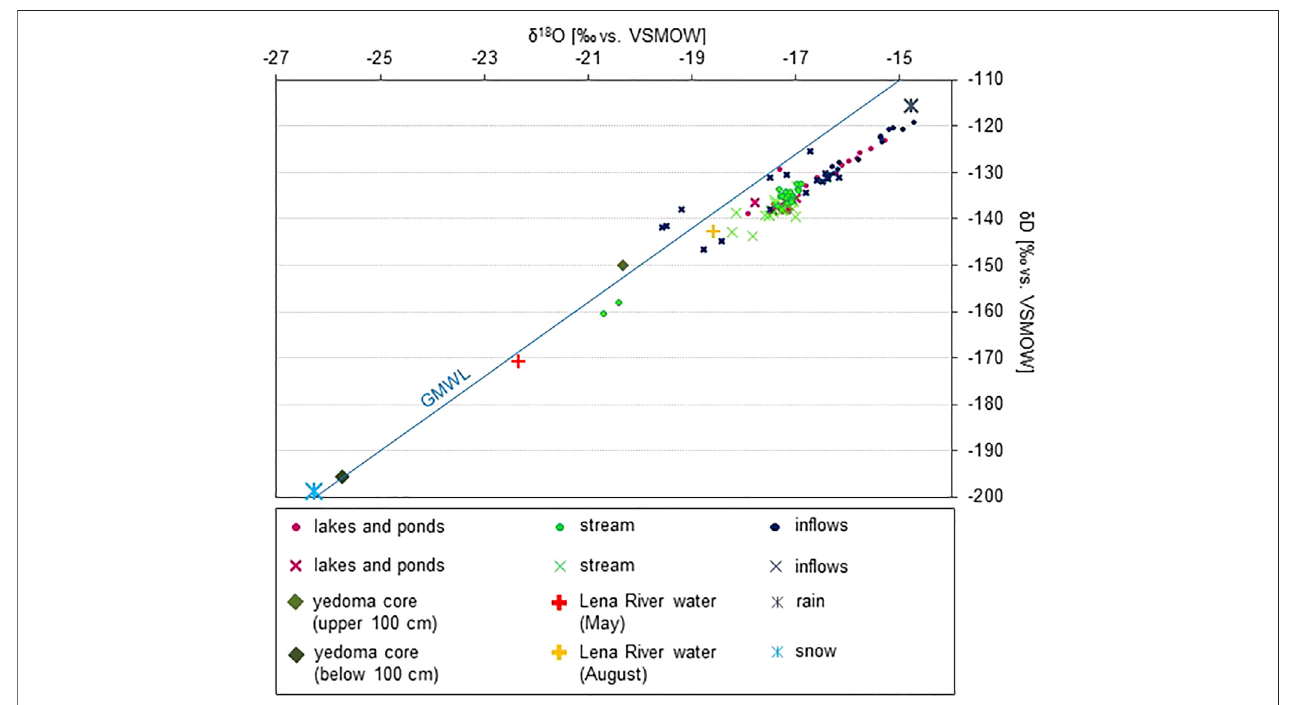
FIGURE5| δ Dand δ 18 Ovaluesoflakesandponds,LuckyLakestream,andin fl owsintheLuckyLakecatchmentbyHolocenenon-yedoma(dots)andPleistocene yedoma (crosses). As references we added δ D and δ 18 O values of Lena River water samples from May and August 2014, rain and snow samples from Bykovsky Peninsula in the Lena River Delta (Meyer et al., 2002), a yedoma core collected north of the Lucky Lake catchment, and the GMWL.